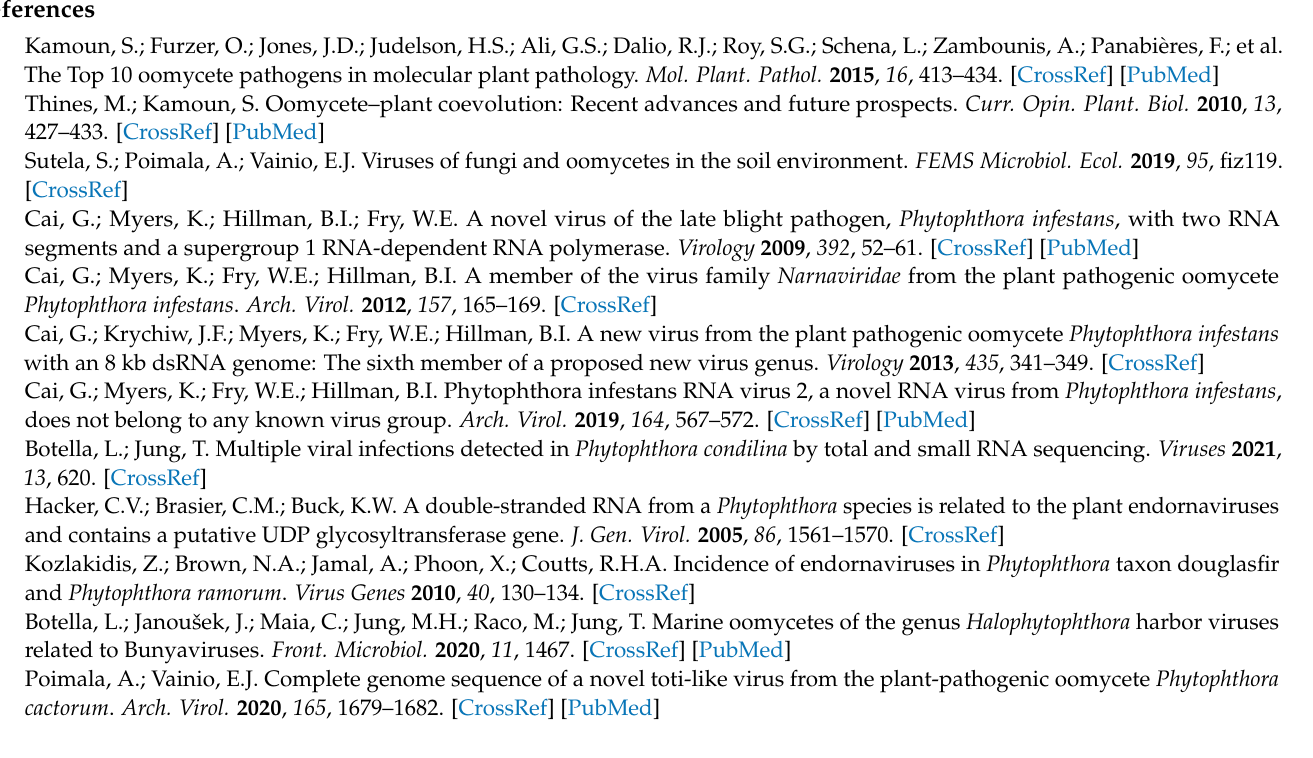
Table S2: Primers used in this study, Table S3: Hits resulting from the tBLASTx search of the PuRV1 ORF, Table S4: List of viruses used for molecular phylogenetic analysis of PuRV1, Table S5: Hits resulting from the tBLASTx search of the PuRV2 ORF2, Table S6: List of viruses used for molecular phylogenetic analysis of PuRV2, Table S7: Relative synonymous codon usage (RSCU) of oomycetes and fungi genes, Table S8: The similarity index D(A,B) value of codon usage bias among oomycetes and